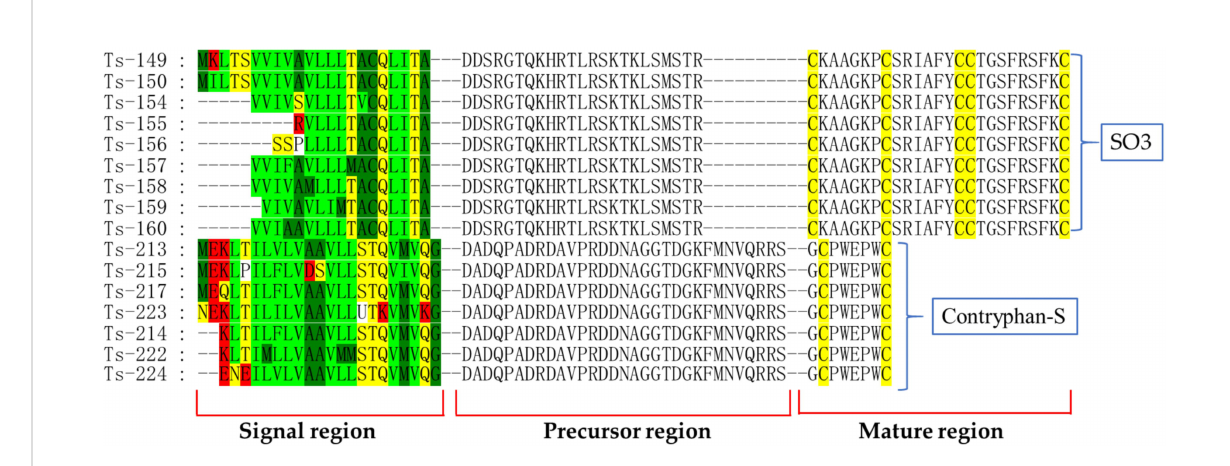
FIGURE 8 Alignment of same mature regions but different signal regions in the O superfamily sequences from our C. striatus